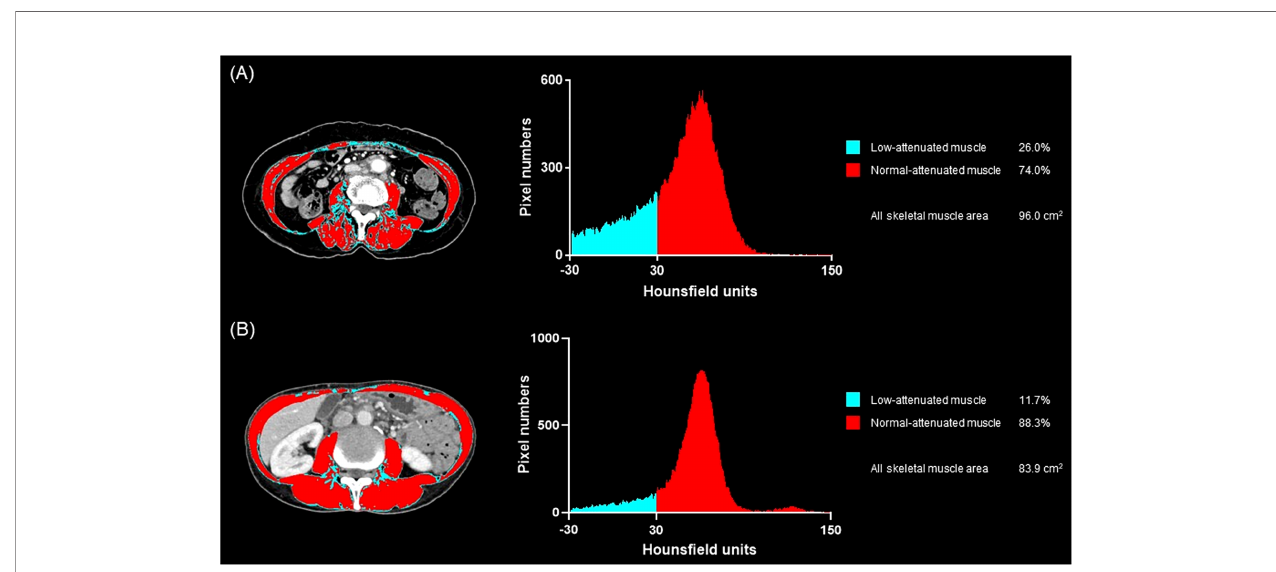
FIGURE 3 | Representative cases of low muscle mass with or without myosteatosis and the occurrence of treatment-related toxicity. (A) A 66-year-old woman treated with gemcitabine monotherapy. She had pre-treatment BMI of 21.2 kg/m 2 and the baseline skeletal muscle index of 40.0, suggesting that her muscle mass was low. The muscle quality map and histogram analysis show the low-attenuated muscle area (blue) is 26.0% of the skeletal muscle area (blue plus red) suggesting that she also had myosteatosis. She experienced grade 3 neutropenia at day 15 after treatment initiation, and the chemotherapy schedule was delayed. (B) A 55- year-old woman who underwent gemcitabine plus nab-paclitaxel, in whom the baseline BMI was 15.0 kg/m 2 and the skeletal muscle index was 33.3, suggesting low muscle mass, more severe than the patient in (A) . The muscle quality map shows the low-attenuated muscle area (blue) is only 11.7% of the skeletal muscle area (blue plus red) suggesting the absence of myosteatosis. She did not experience any toxicity during the fi rst cycle of